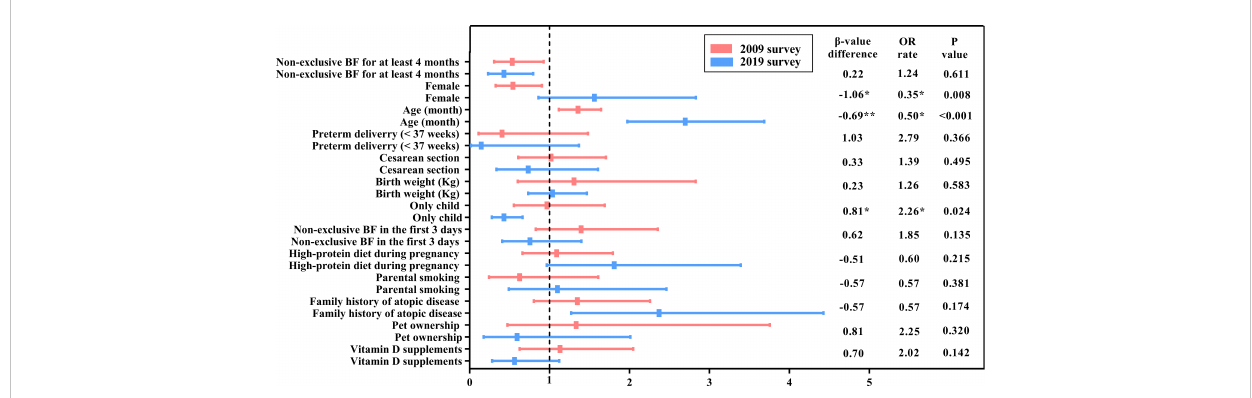
FIGURE 2 A comparison of the change in food sensitization risk factors between the 2009 and 2019 surveys. BF, Breastfeeding; OR, Odds ratio. The names of the variables in the table (including the results of the classi fi cation) are calculated in the model, except for age, which is classi fi ed as a rank variable from younger to older. P-value * means P<0.05; ** means P<0.01.